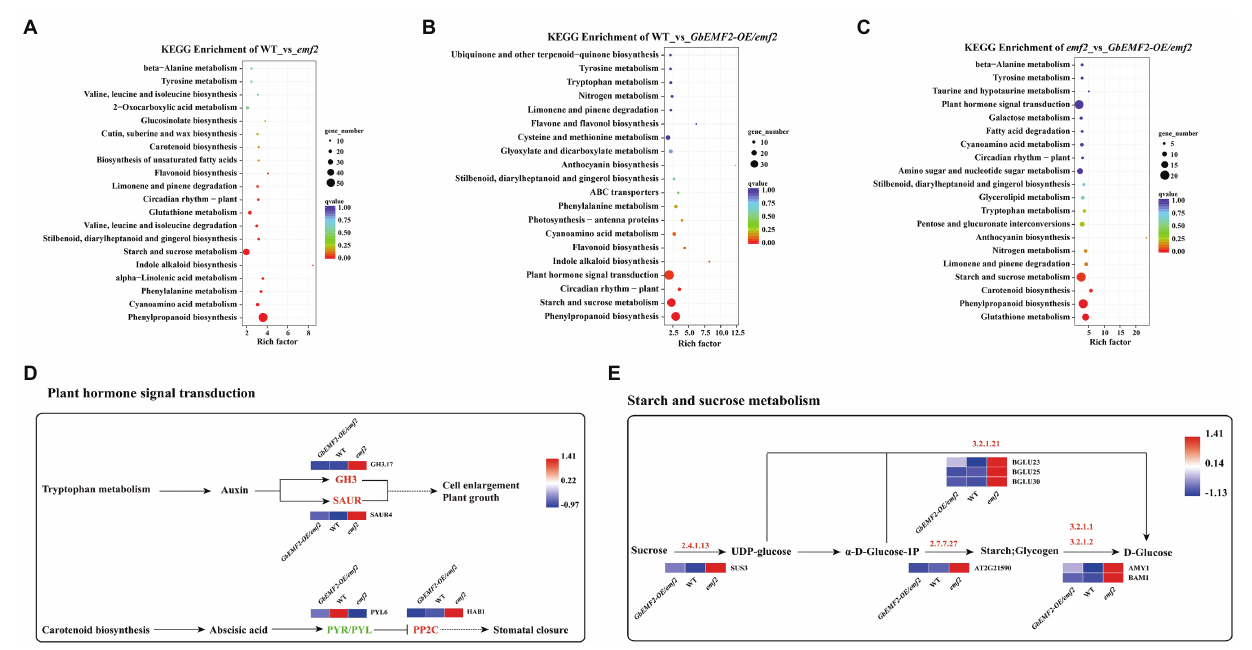
FIGURE 7 | Analysis of DEGs of Kyoto Encyclopedia of Genes and Genomes (KEGG) pathway. (A) Analysis of DEGs of top 20 KEGG pathway in WT _ vs _ e mf2 . (B) Analysis of DEGs of top 20 KEGG pathway in WT _ vs _ GbEMF2-OE / emf2 . (C) Analysis of DEGs of top 20 KEGG pathway in e mf2 _ vs _ GbEMF2-OE / emf2 . (D) The KEGG metabolic pathway of plant hormone signal transduction. Red indicates that the Fragments Per Kilobase of transcript per Million mapped reads (FPKM) value of genes is high, and blue indicates that the FPKM value of genes is low screened from KEGG orthology (KO) database. (E) The KEGG metabolic pathway of starch and sucrose. Red indicates that the FPKM value of genes is highly, and blue indicates that the FPKM value of genes is low screened from KO